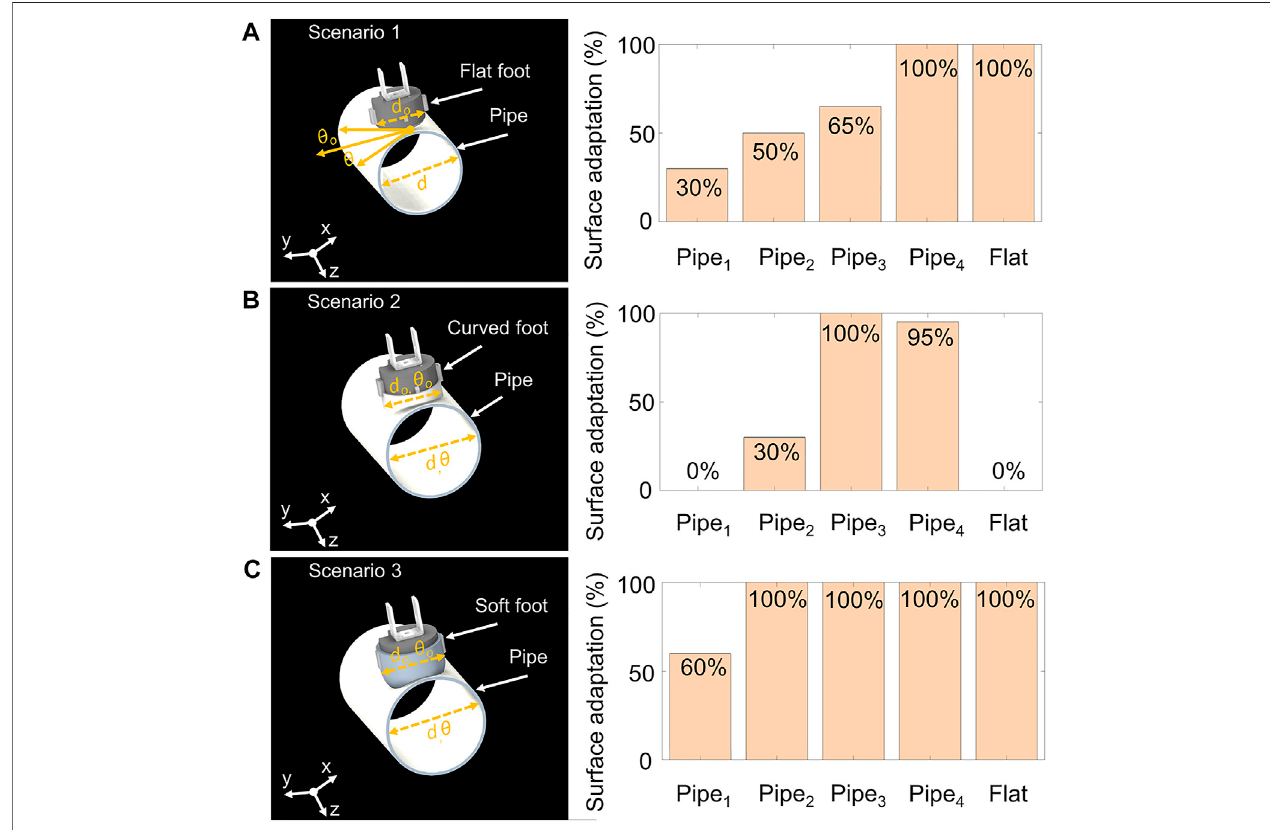
FIGURE 7 | An experiment to compare and analyze the percentage foot-adaptation on different metal surfaces when the bottom of the robot foot was fl at, curved withtherigidtoe,andthesofttoe.Thisexperimentwasusedtoconsiderinstancesinwhichtherobotfailedacrawlingexperimentsolelybecauseofmismatchingfeetand a curvature in the crawling surface. (A) The fi rst scenario shows that the fl at robot foot ( diameter = d o ) adhered to a metal pipe ( diameter = d ), where the angle formed betweenthefootface(shownas θ o )andpipe(shownas θ )contributedtofoot-adaptationwhenfullyattachedtoametalpipe.Herethepipes 1,2,3,4 havediametersof 12 (minimum case), 16 (medium case), 22 (practical case), and 60 cm (potential case), respectively. (B) The second scenario utilized the curved rigid foot-toe, and its surface adaptation demonstrated on all test surfaces. (C) The third scenario employed the soft curved foot-toe, and the resulting surface adaptation can be observed.